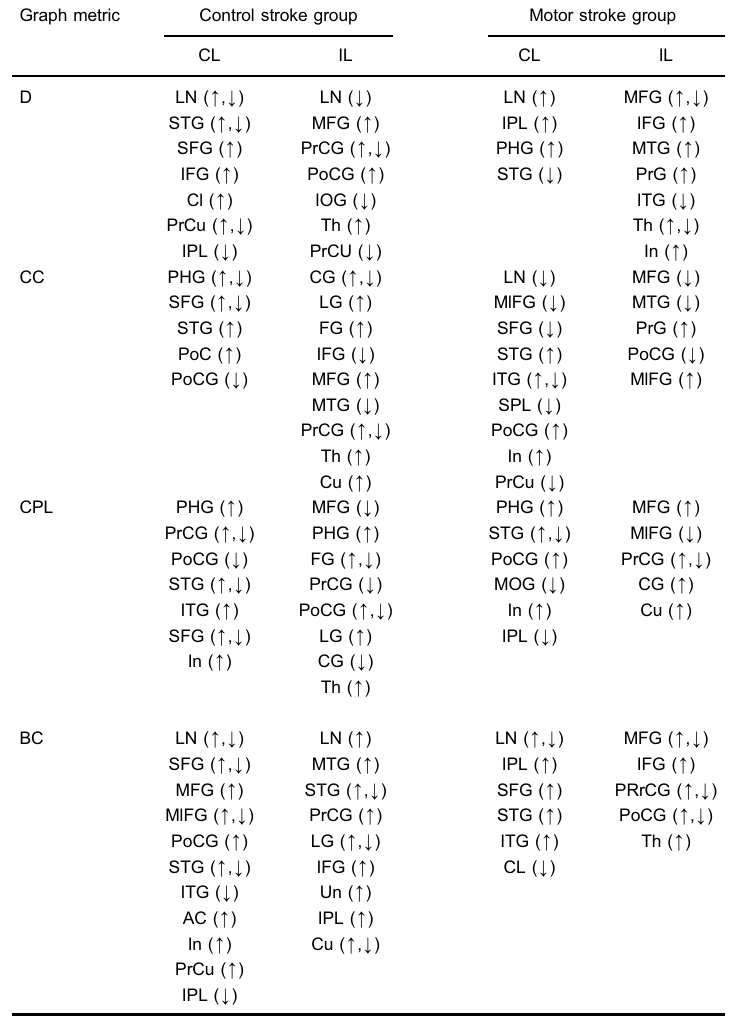
Table 3. Increase ( m ) or decrease ( k ) of graph metrics in the motor stroke and control stroke